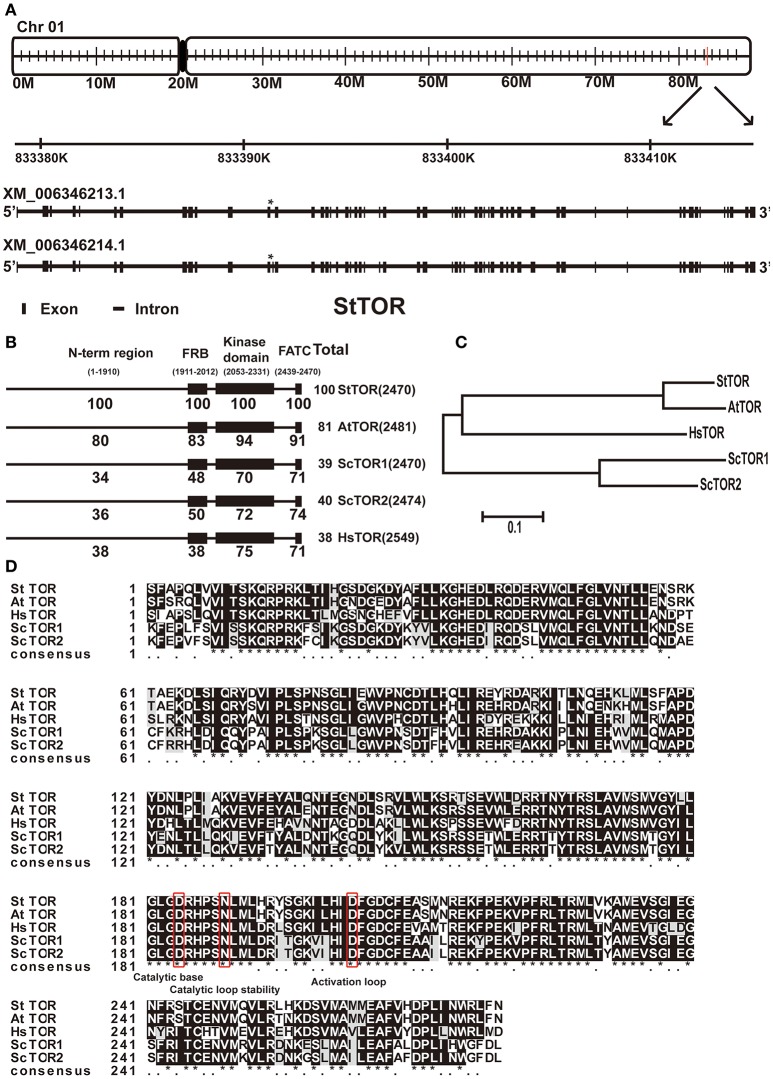
Conservative evolution of StTOR in potato. (A) The location of StTOR in chromosome and the difference of two different transcripts of StTOR in potato. The difference places of two transcripts were marked with *. (B,C) Similarity comparison of protein and phylogenetic tree between StTOR and its homologs from other species (St, Solanum tuberosum, At, Arabidopsis thaliana, Sc, Saccharomyces cerevisiae, Hs, Homo sapiens). N-term region includes HEAT repeats domain and FAT domain. (D) Comparison of kinase domain of StTOR and its homologs from other species. The conserved sites (catalytic base, catalytic loop stability, and activation loop) were marked with red box.